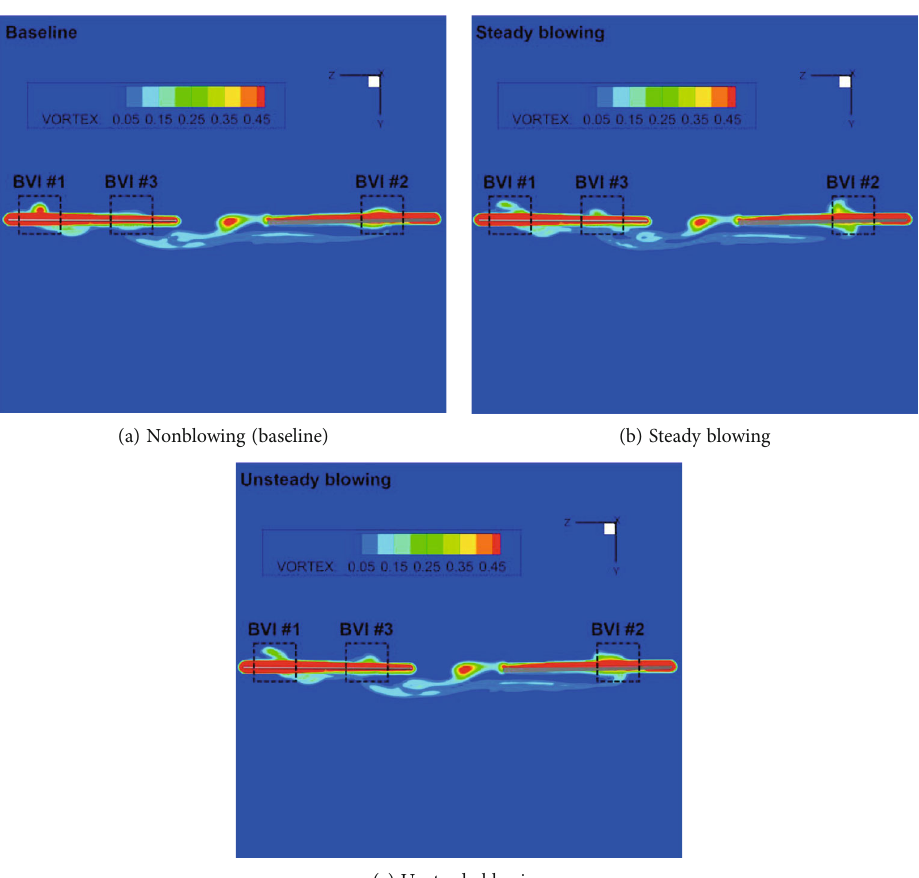
Figure 13: Vorticity contours at the cutting plane of X = 0 at 90 ° azimuthal angle for the steady/unsteady blowing